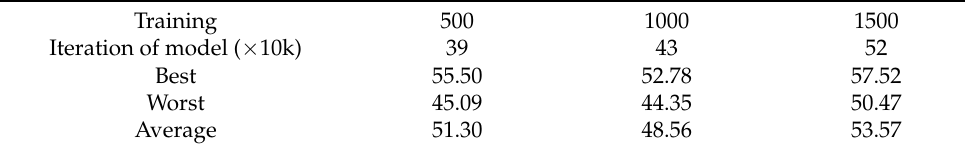
Table 6. YOLOv3 Analysis of the training process (mAP = 0.5, Testing sets = 166). Training